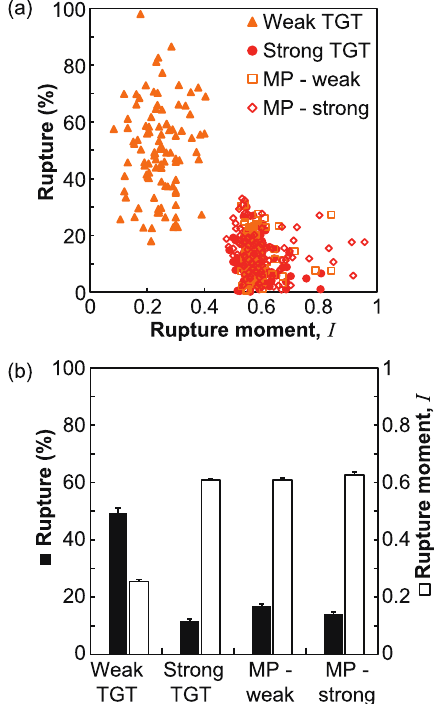
FIG. 3 Single cell analysis of TGT rupture pattern. (a) More than 400 cells are selected and analyzed based on two variables: percent rupture and rupture moment ( I ). Each symbol represents one single cell. Percent rupture and rupture moment for the weak TGT-coated surface (Weak TGT) are characteristic of “ uniform rupture ” and are clearly different from “ edge rupture ” character- istics seen for the strong TGT surface (Strong TGT), and for the weak and strong TGTs on the MP surface (MP – weak and MP – strong, respectively). (b) Average values from (a). Error bars denote standard errors of